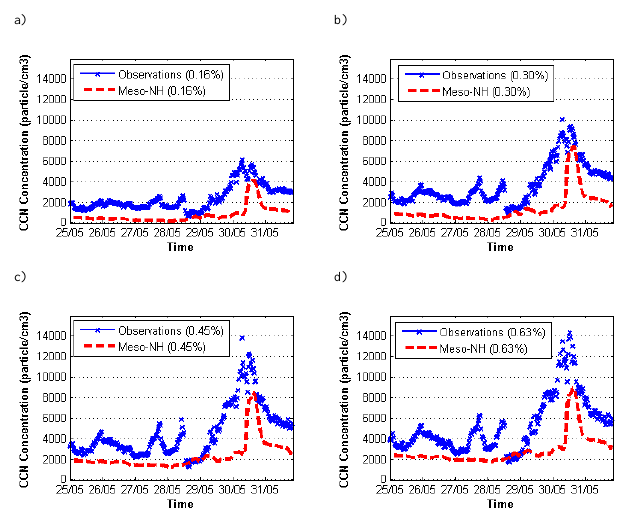
Figure 13. Evolution of the CCN concentration at water vapor su- persaturation of (a) 0.16%, (b) 0.30%, (c) 0.45% and (d) 0.63% measured (blue line) and calculated from the simulation (red line) at Cabauw between 25 and 30 May